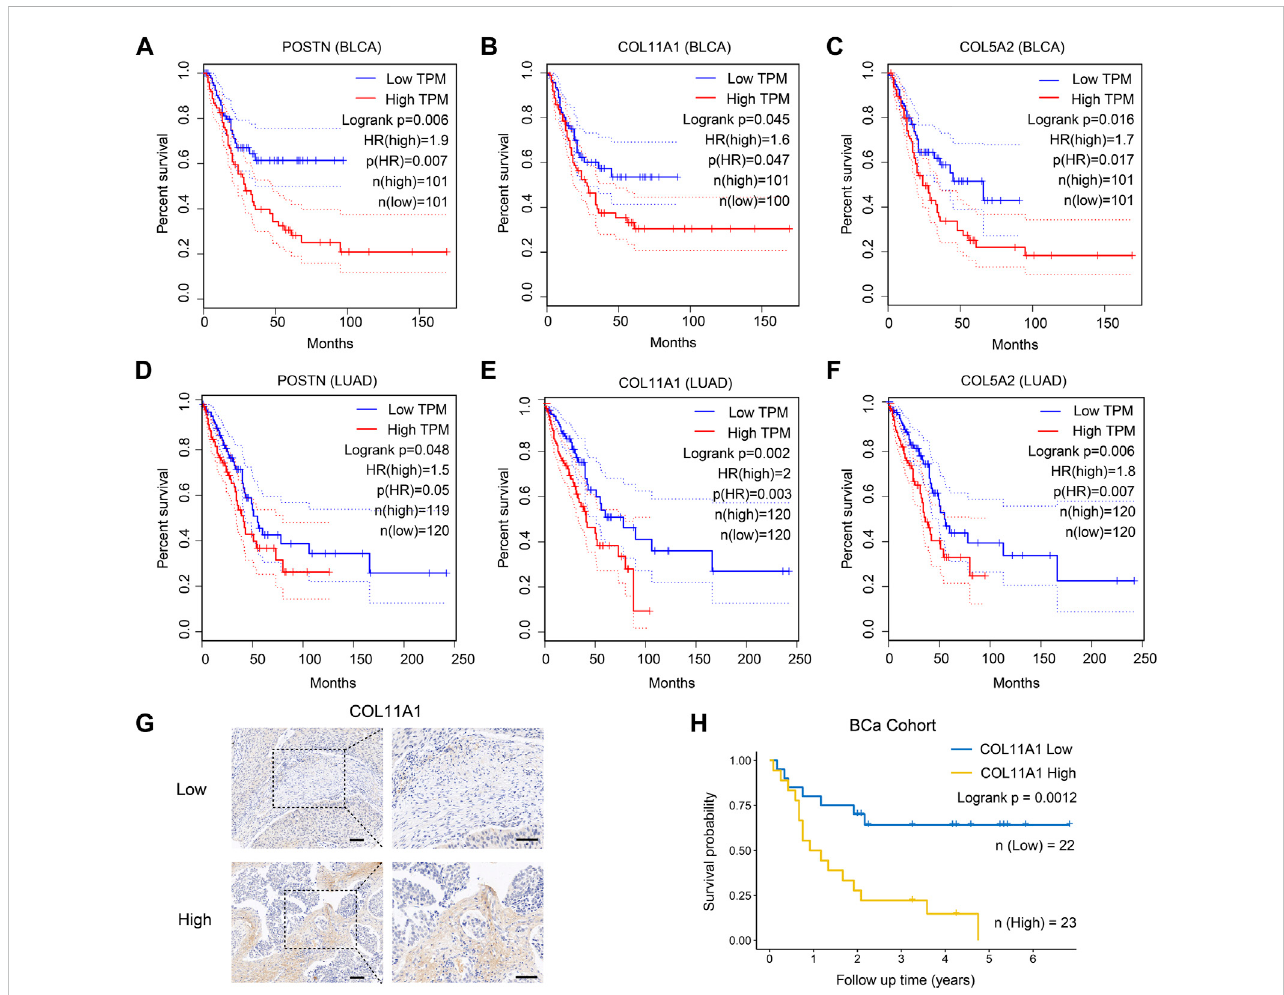
FIGURE 6 ECMassociatedgenesarehighlyexpressedinCSFsandassociatedwithpatients ’ prognosis. (A – C) ,Overallsurvivalofpatientswithdifferentexpressionof the three highly expressed genes in CSFs, including POSTN (A) , COL11A1 (B) and COL5A2 (C) in TCGA BLCA cohort. (D – F) , Overall survival of patients with differentexpressionofthethreehighlyexpressedgenesinCSFs,includingPOSTN (D) ,COL11A1 (E) andCOL5A2 (F) inTCGALUADcohort. (G) ,IHCanalysis